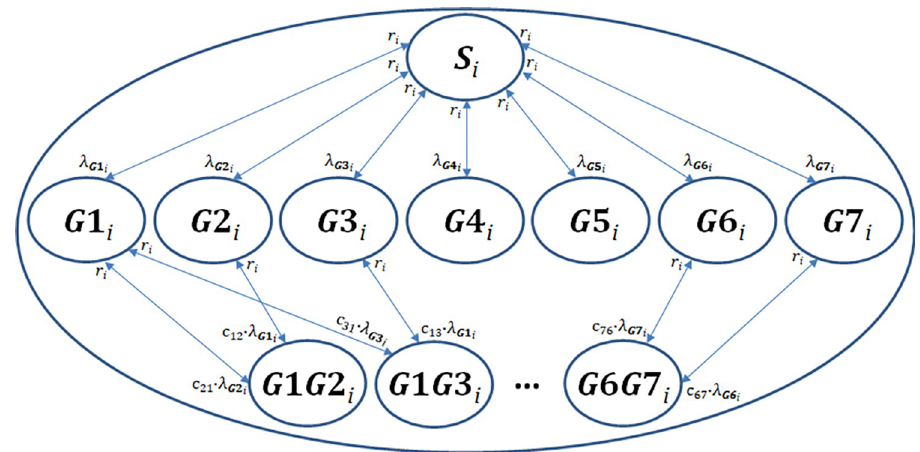
Fig 1. Scheme of the epidemiological model. We assumed acquisition and loss of carriage to be stepwise processes, i.e., non-carriers can become single carriers, who can become double carriers or non-carriers again; double carriers first become single carriers before becoming non-carriers again. For a detailed description see text. S :